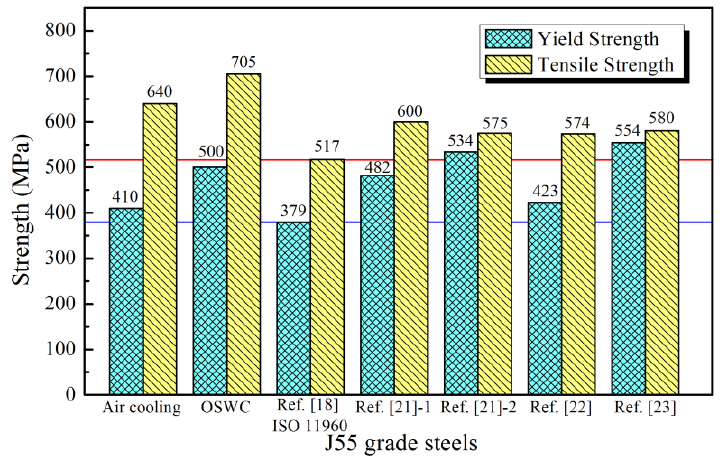
Figure 10. Strengths of J55-grade steels reported in the literature.